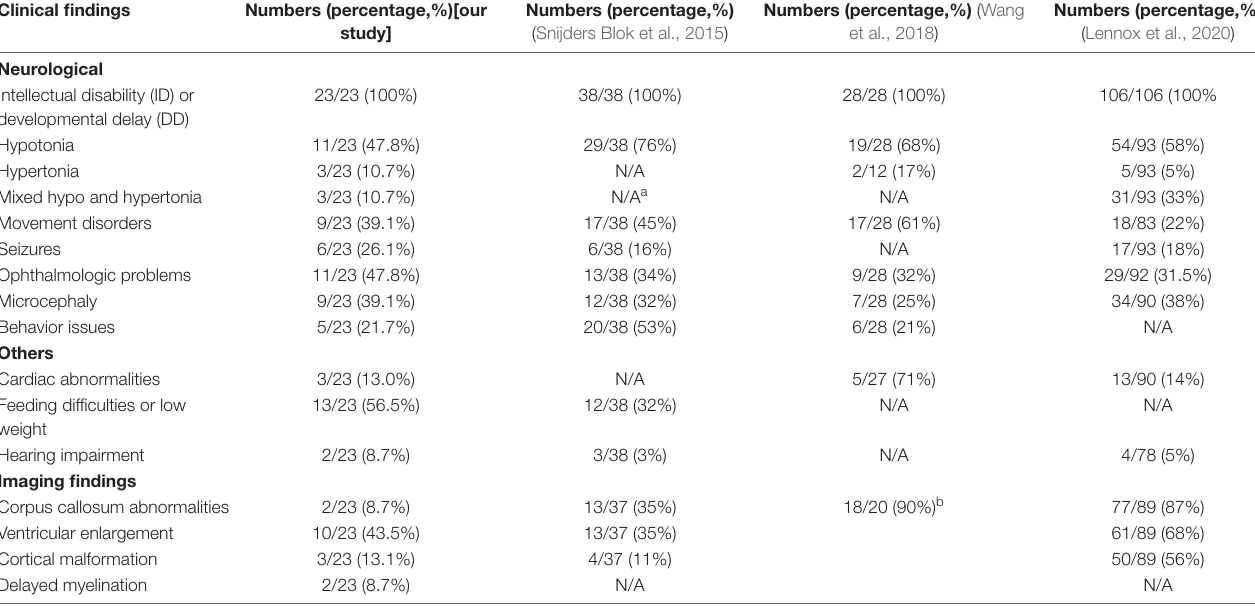
TABLE 3 | Comparison of clinical characteristics in our cohort and three previously published cohorts. Clinical